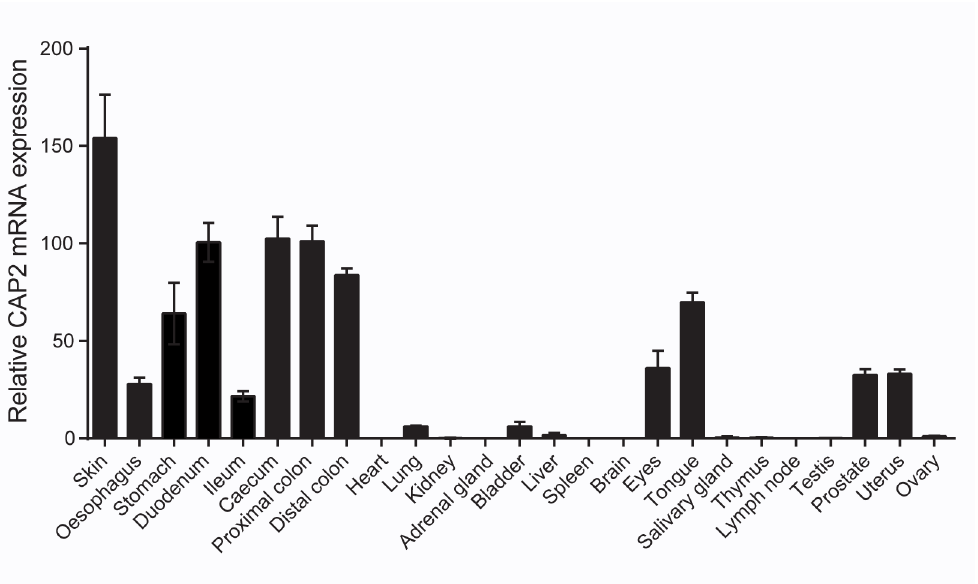
Fig 1. Distribution of wildtype CAP2/ Tmprss4 mRNA transcript expression. CAP2/ Tmprss4 mRNA expression profile in WT mice (n = 4) in various organs as indicated; individual values were normalized to β -actin.